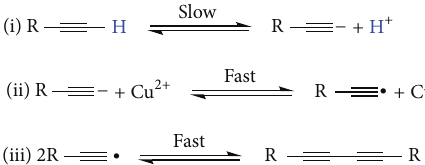
Scheme 1: General form of the Eglinton oxidative homocoupling of alkynes.